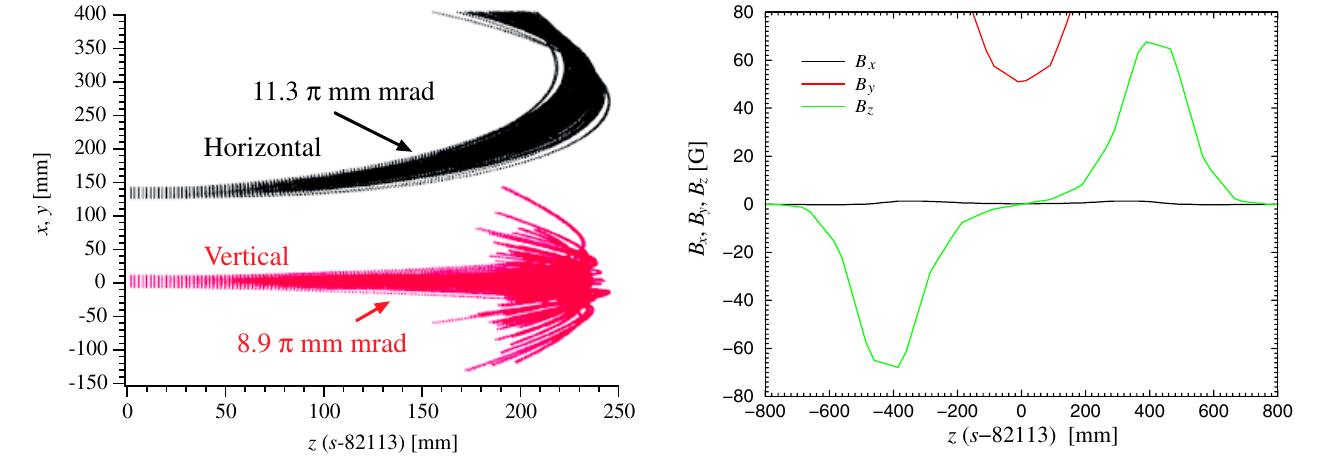
FIG. 11. (Color) Stripped electron trajectory. The stripping foil is placed at z (cid:4) 0 . The black line is for the horizontal plane, and the red line is for the vertical plane (200